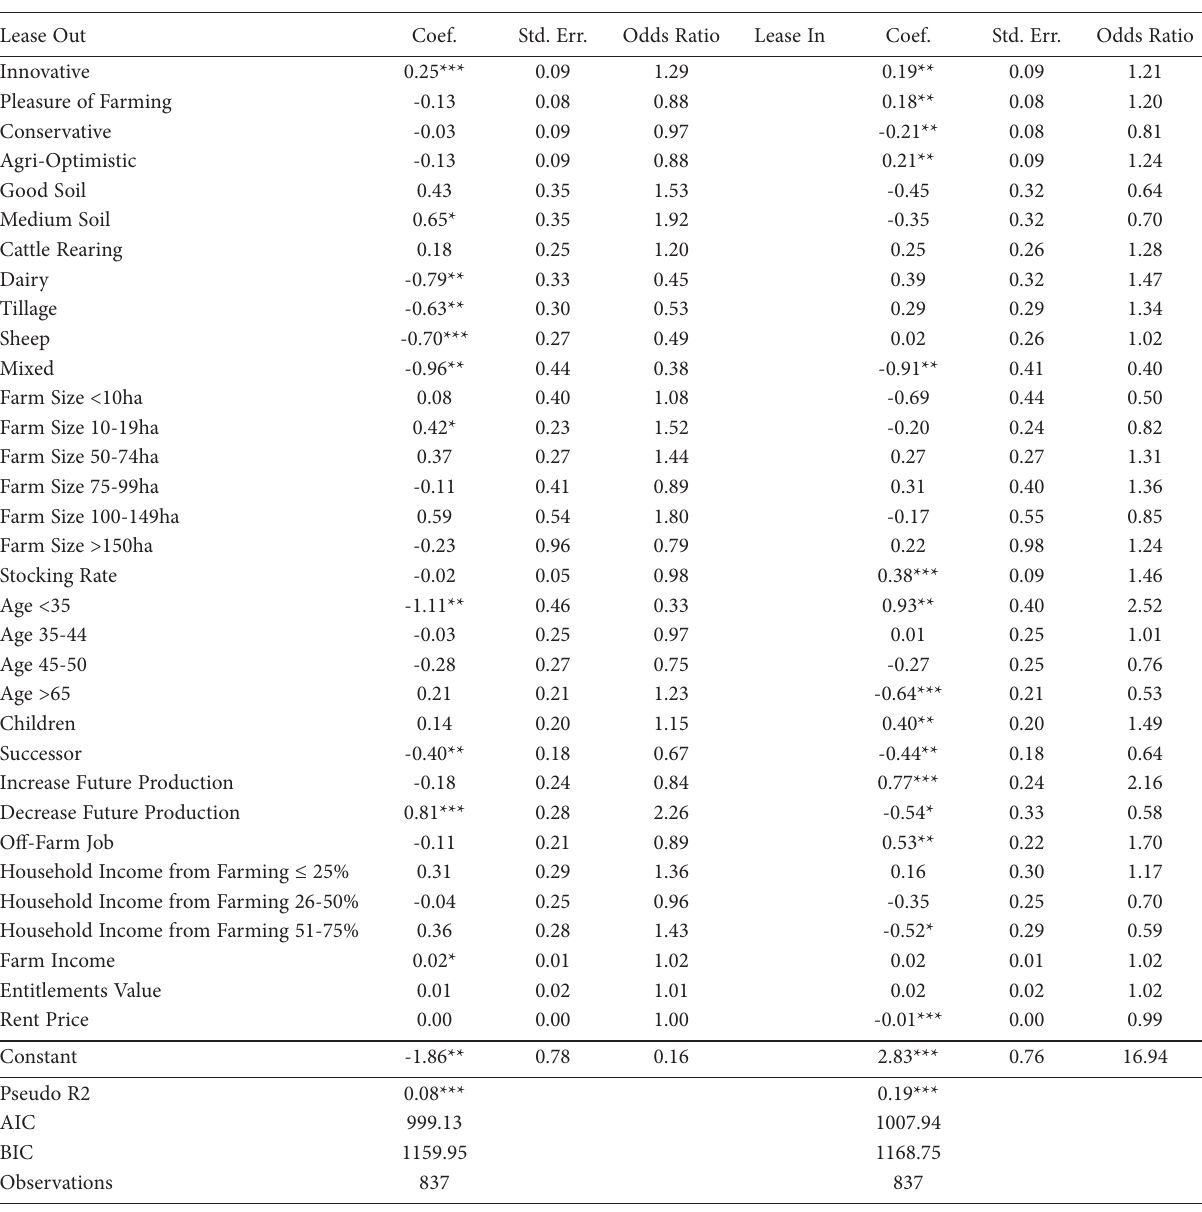
Table 5. Factors related to the probability farmers are open to leasing land. Lease Out Coef. Std.